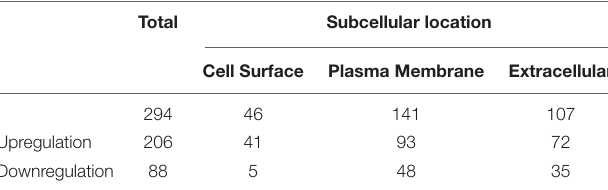
TABLE 1 | The number of upregulated or downregulated proteins and their subcellular location.